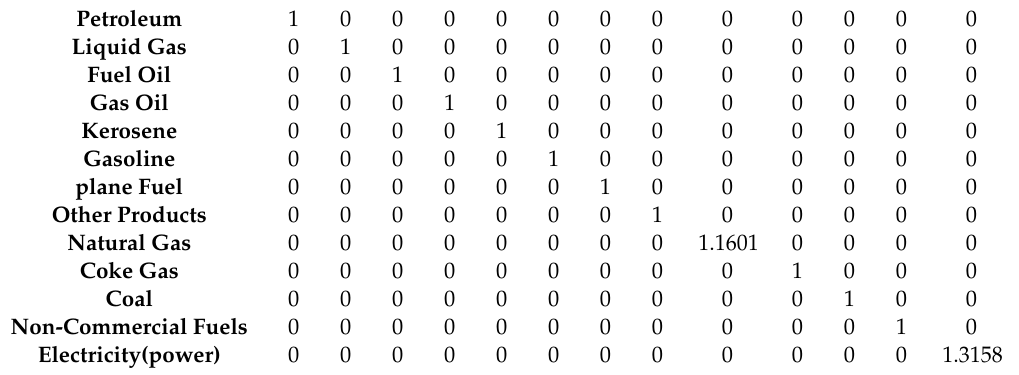
Table A7. Matrix T 23